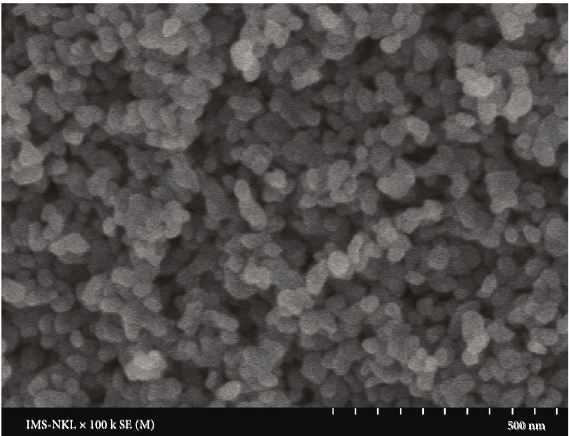
Figure 2: RM treated with 4 N hydrochloric acid and heat treatment at 750 ° C.